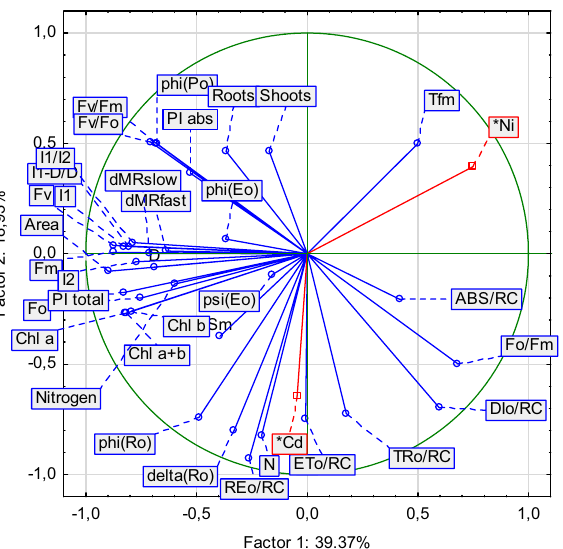
Figure 7. Principal component analysis of two heavy metals (Ni and Cd) effects on the photosynthetic machinery of leaves of two species of ryegrass: ‘Niga’;